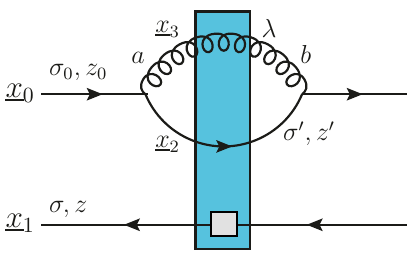
Figure 7 . A more detailed rendering of the diagram